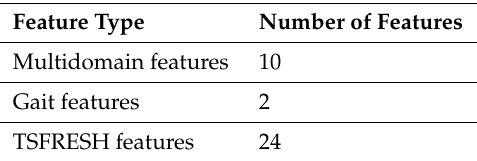
Table 10. Feature combination after